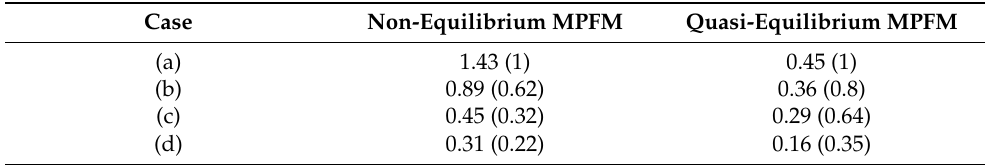
Table 2. Average cell space ( µ m) at a steady interface moving velocity if 0.1 m/s. Numbers in parentheses are ratios of the cell space in which the space of case (a) is defined as a unit.